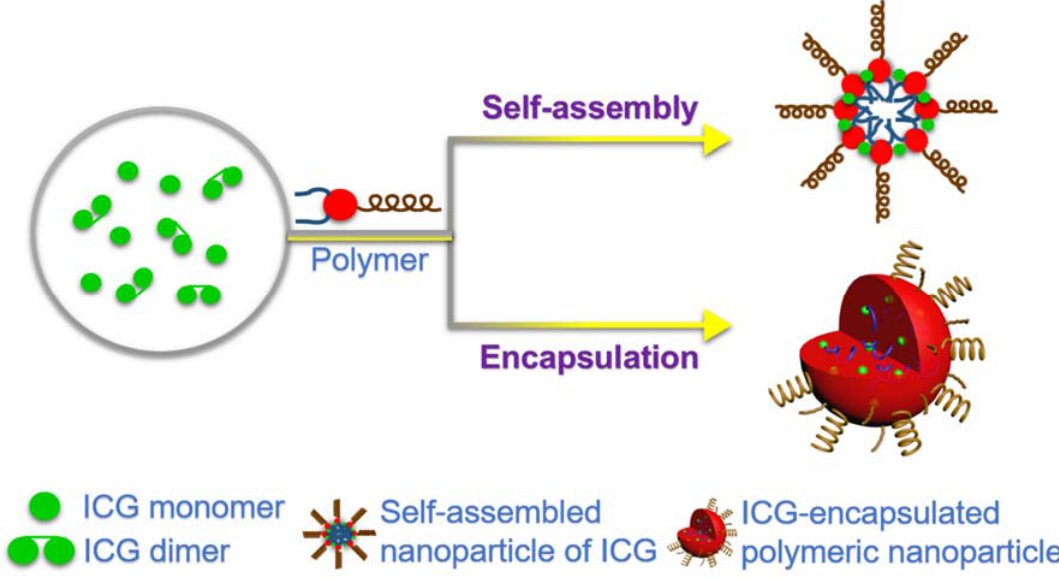
Figure 3. The molecular rearrangements and various delivery patterns of ICG.